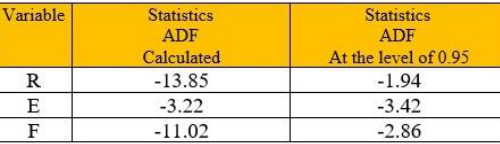
Table 7: Pearson Correlations Test for the relationship between Municipality’s Income and Foreign Exchange between 2006